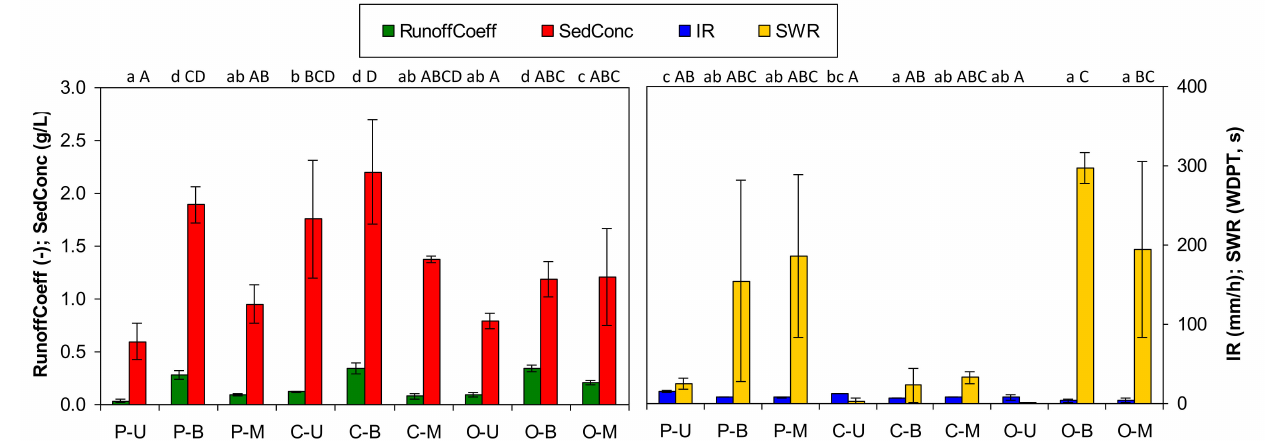
Figure 2. Hydrological observations ( left , RunoffCoeff = runoff coefficient and SedConc = Sediment Concentration; right , IR = infiltration rate and SWR = soil water repellency) in the experimental sites measured immediately after the prescribed fire and mulching treatment (Samo, Calabria, Southern Italy). Legend: P = pine; C = chestnut; O = oak; U = unburned; B = burned and not treated; M = burned and mulched; different letters indicate significant differences among the soil conditions and forest species after Tukey’s test ( p < 0.05); lowercase letters refer to RunoffCoeff and IR, capital letters to SedConc and